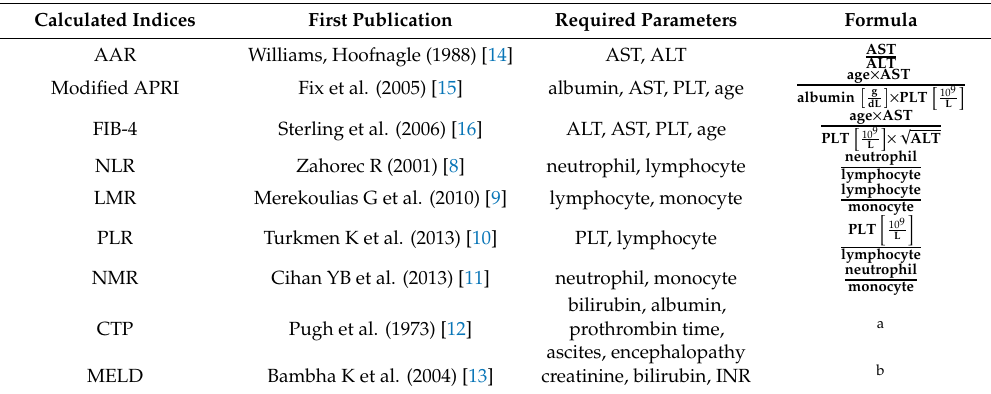
Table 1. Indices calculated using widely available